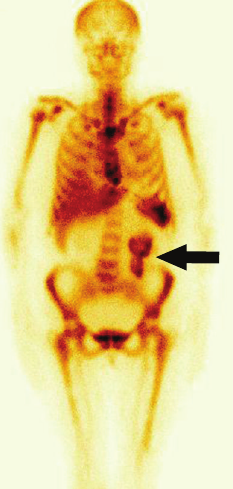
Figure 7: 57-year-old woman with fever of unknown origin without abdomen pain. Whole body inflammation imaging with 99 m Tc- labeled antigranulocyte monoclonal antibodies sulesomab, anterior view.Thegranulocytesuptakeintheileum—m.Crohn( arrowhead ). Normal uptake of the radiotracer in bone marrow.